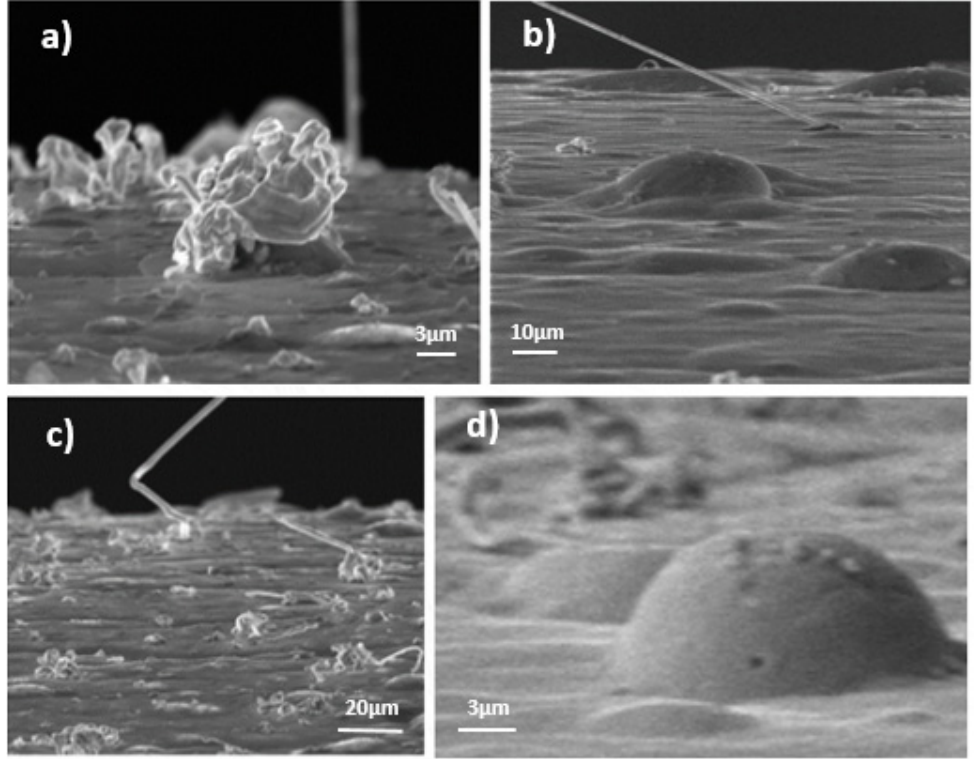
Figure 2. ( a ) Nodular whiskers. ( b ) Rectilinear whiskers and hillocks. ( c ) Whiskers with abrupt changes of direction. ( d ) regular shape of